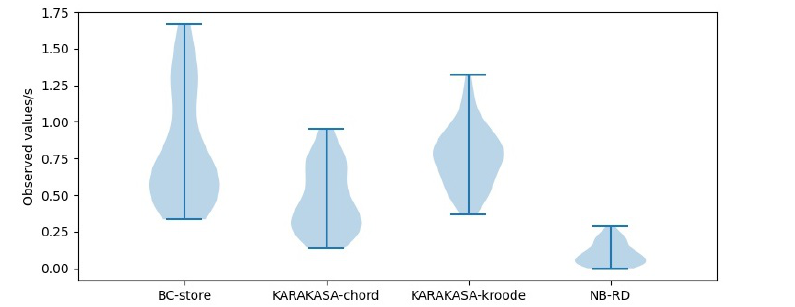
Figure 13. Availability performance in node = 3000.